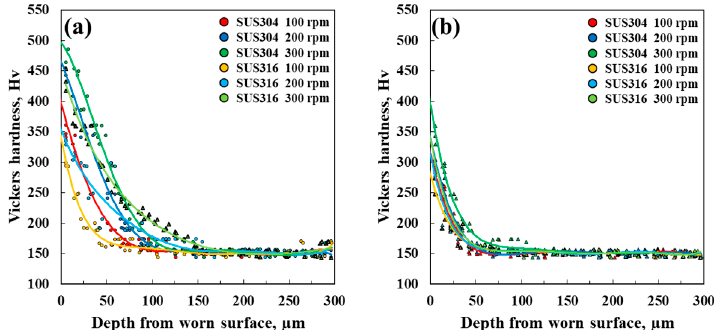
Figure 6. Variation of hardness as a function of distance from worn surfaces of test blocks after wear tests under ( a ) dry and ( b ) wet conditions.